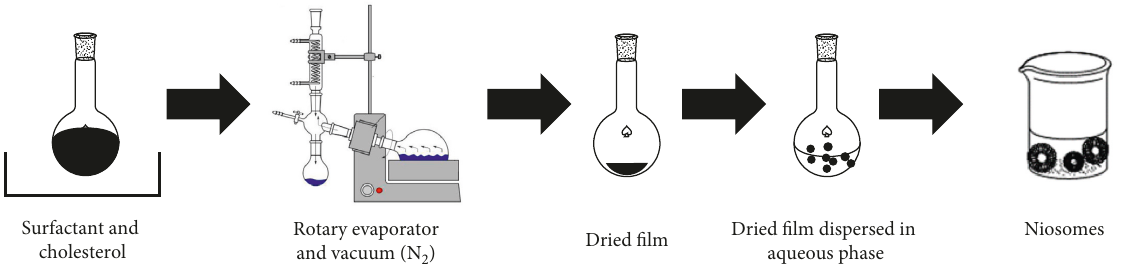
Figure 9: Schematic nonionic surfactant vesicles (niosomes) formation by lipid layer hydration method.